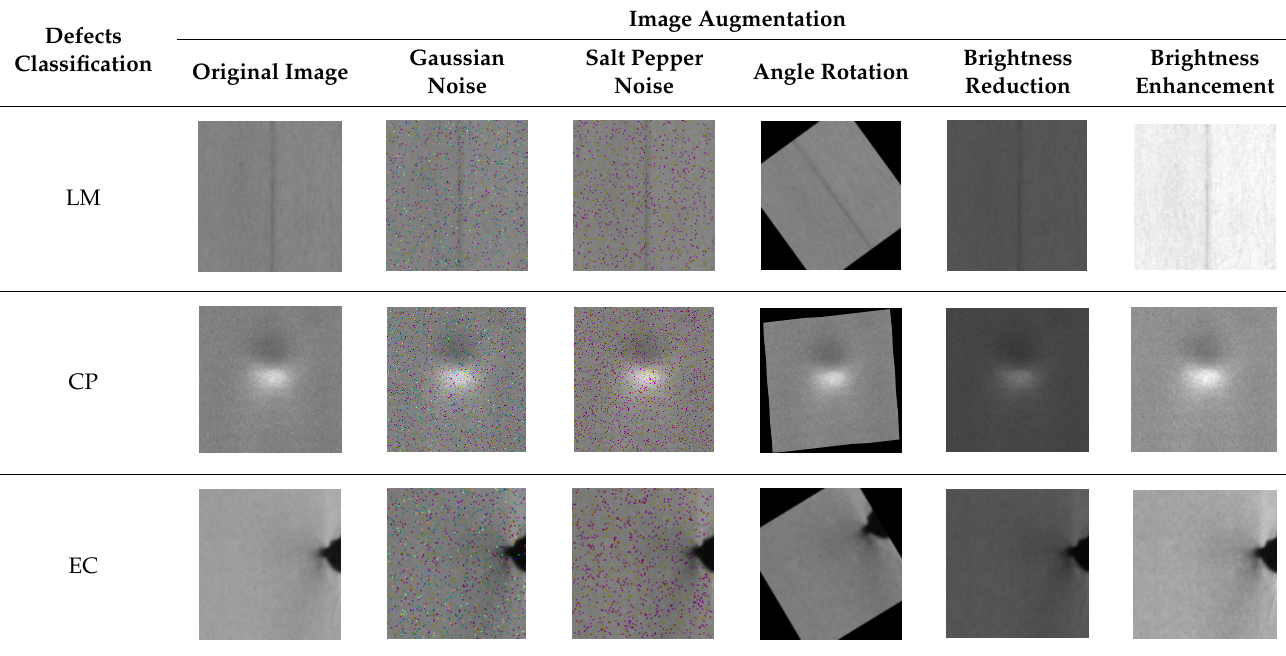
Table 2. Surface defect image data